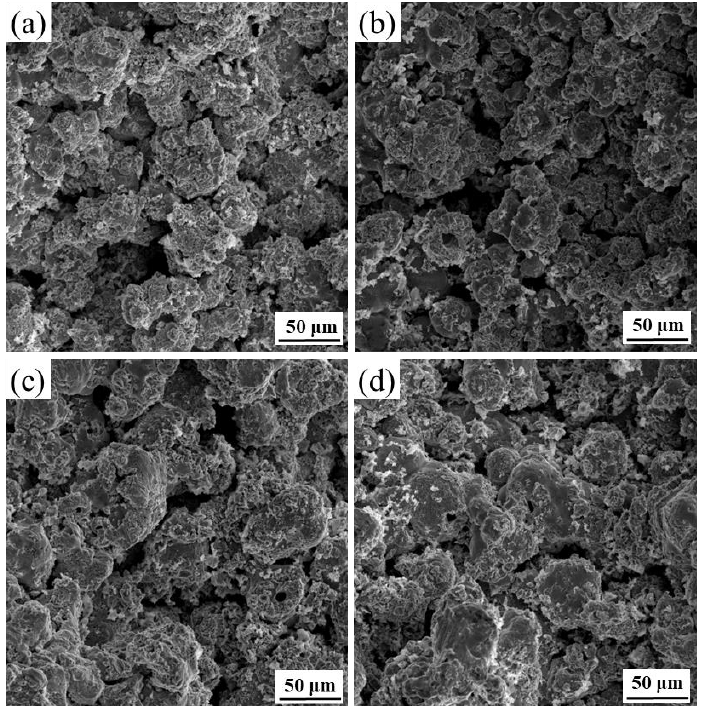
Figure 13. The fracture morphologies of specimens sintered with various solid loading rates: ( a ) 42 vol.%; ( b ) 45 vol.%; ( c ) 48 vol.%; ( d ) 51 vol.%.